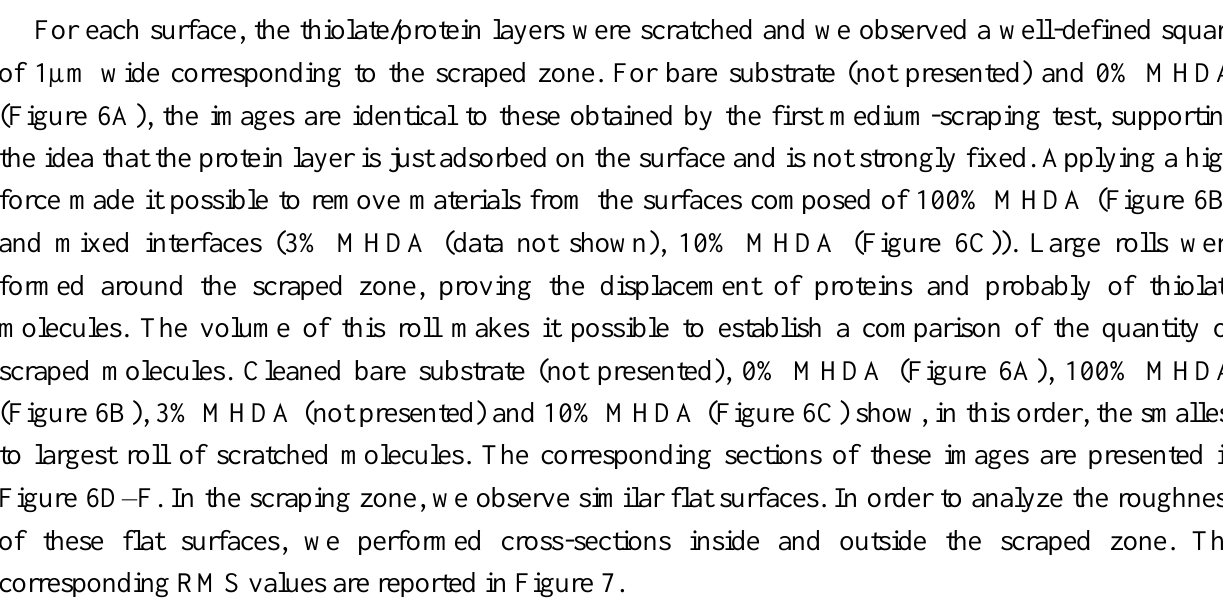
Figure 7. RMS values of protein modified GaAs surfaces, inside and outside the scraped zones, for each chemically modified GaAs